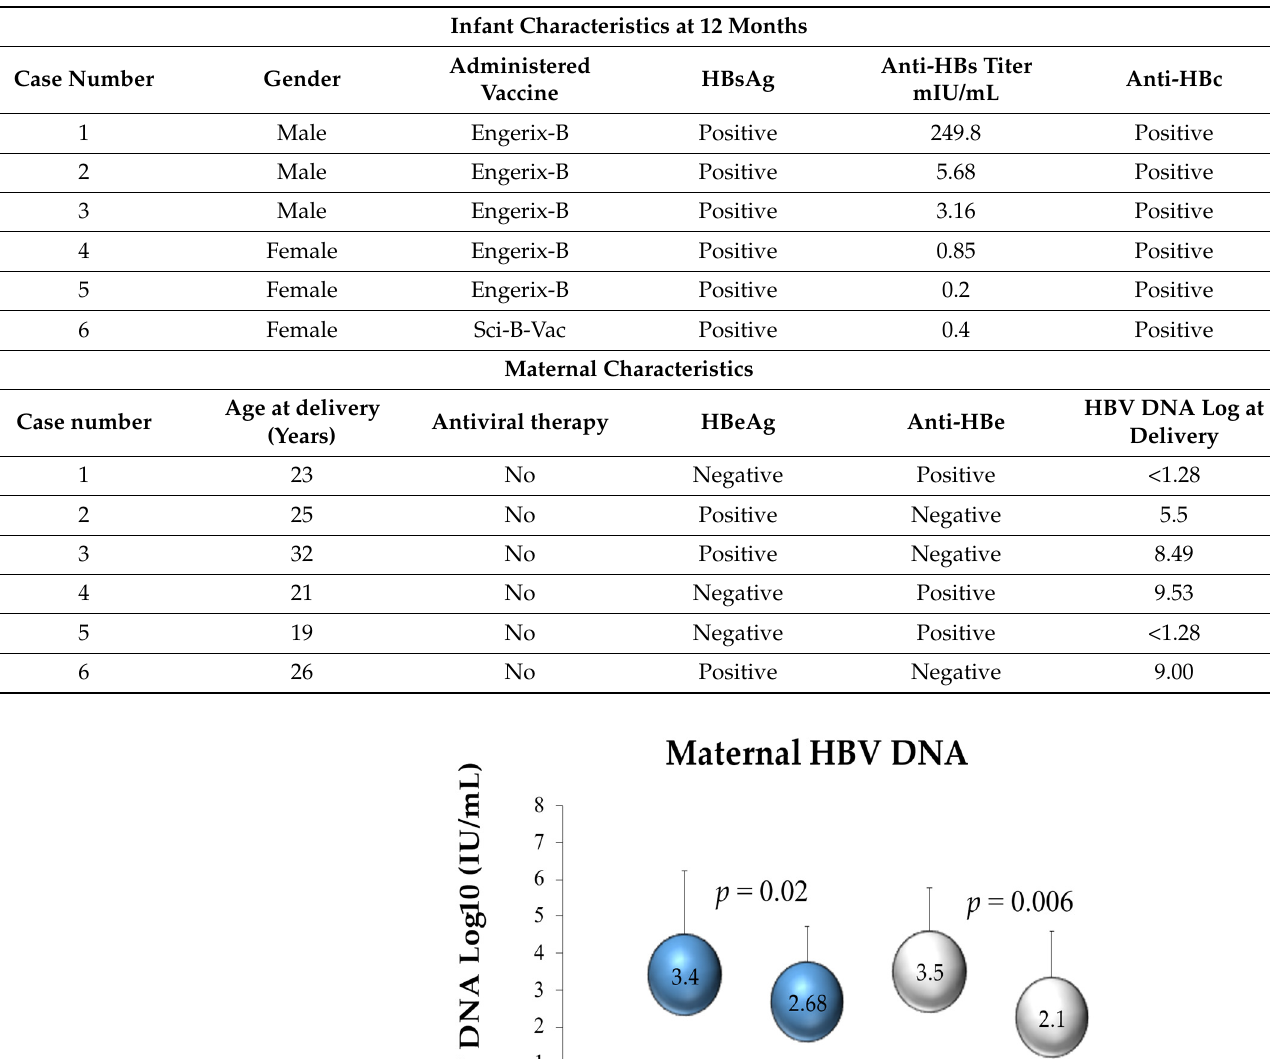
Table 5. Characteristics of the presumed six mother to child HBV transmission (MTCT) cases.